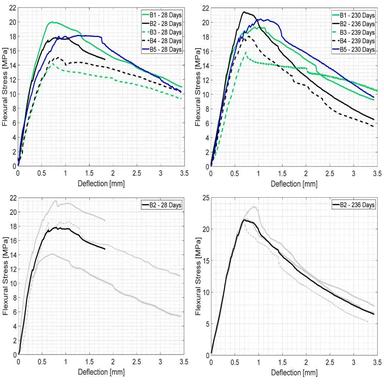
Average flexural stress versus middle deflection relationships for the NP-UHPC prisms tested at different ages.